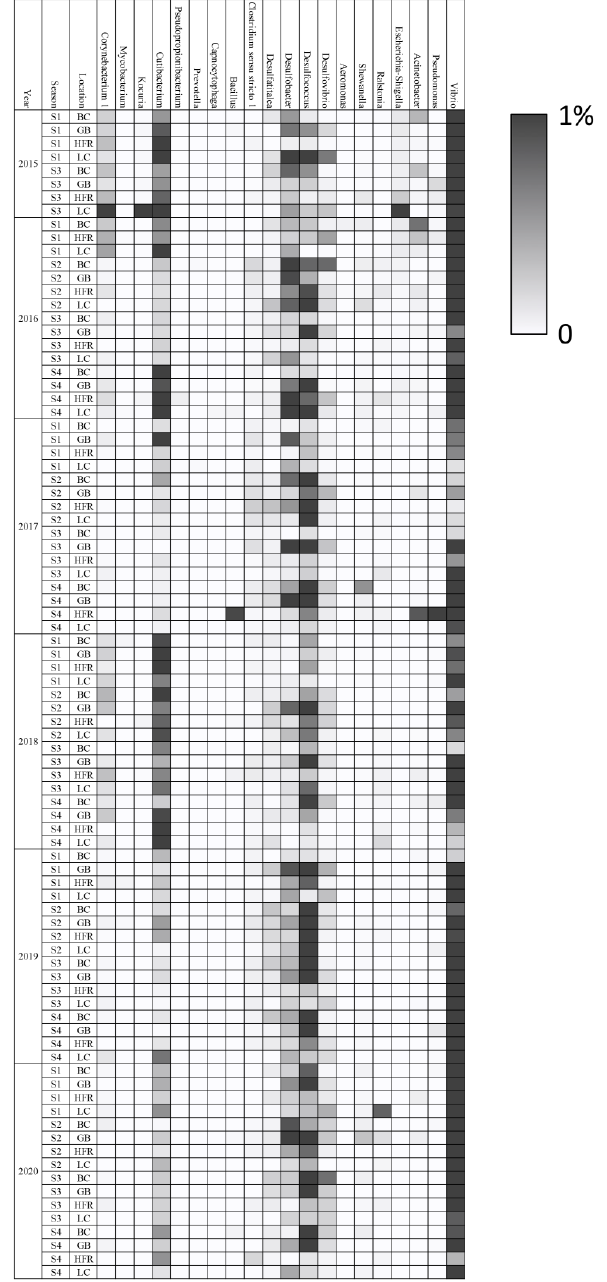
Figure 5. Heat map of the putative pathogen and human-related genera in all samples. The scale is based on relative abundances ranging from 0 to 1%. The BC, GB, HFR, and LC indicate the sites Beauty Cave, Geban Bay, Houshi Fringing Reef, and Lobster Cave, accordingly .